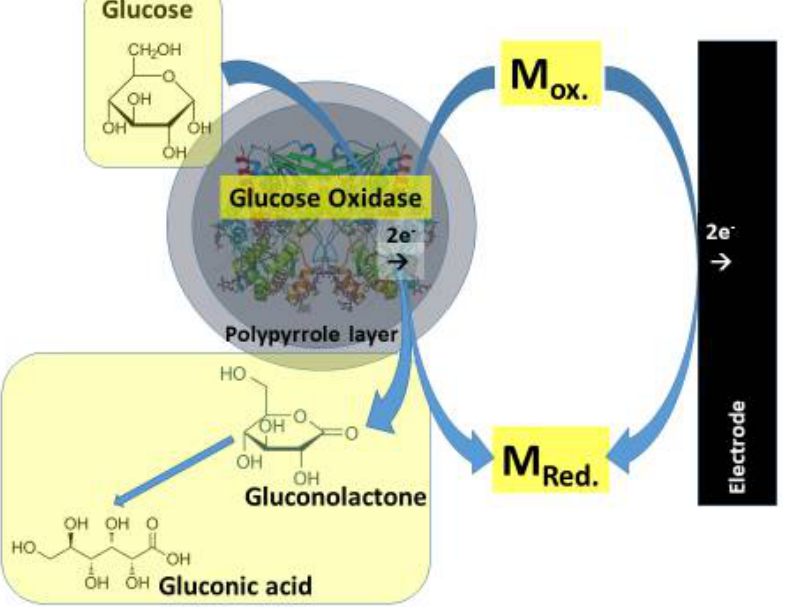
Figure 2. The application of polypyrrole modified glucose oxidase in the design of enzymatic sensor mediated by a redox mediator (M Ox. /M Red. ) system. Phenazine methosulfate, benzoquinone, 2,6-dichlorophenol indophenol, and many others redox compounds can act as redox mediators.